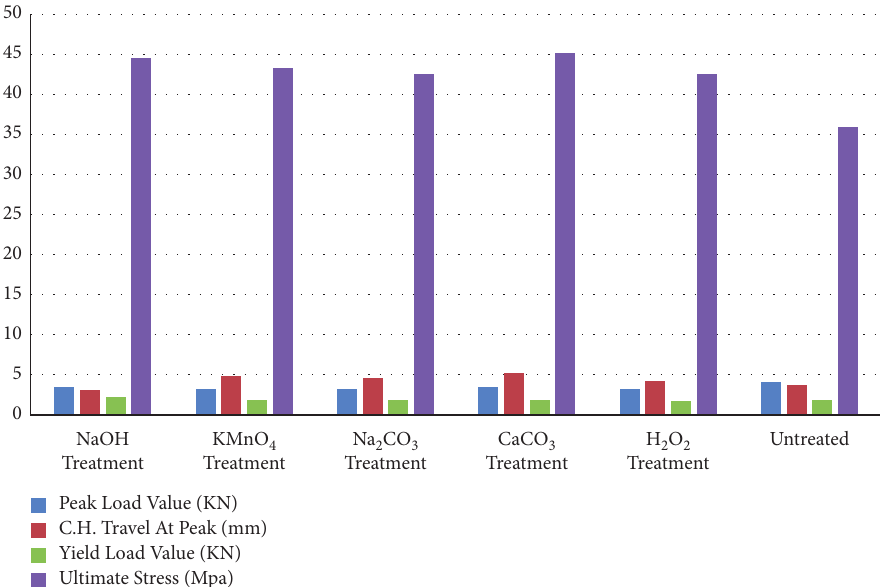
Figure 2: Ultimate tensile strength vs. treated and untreated fibers with polyester.